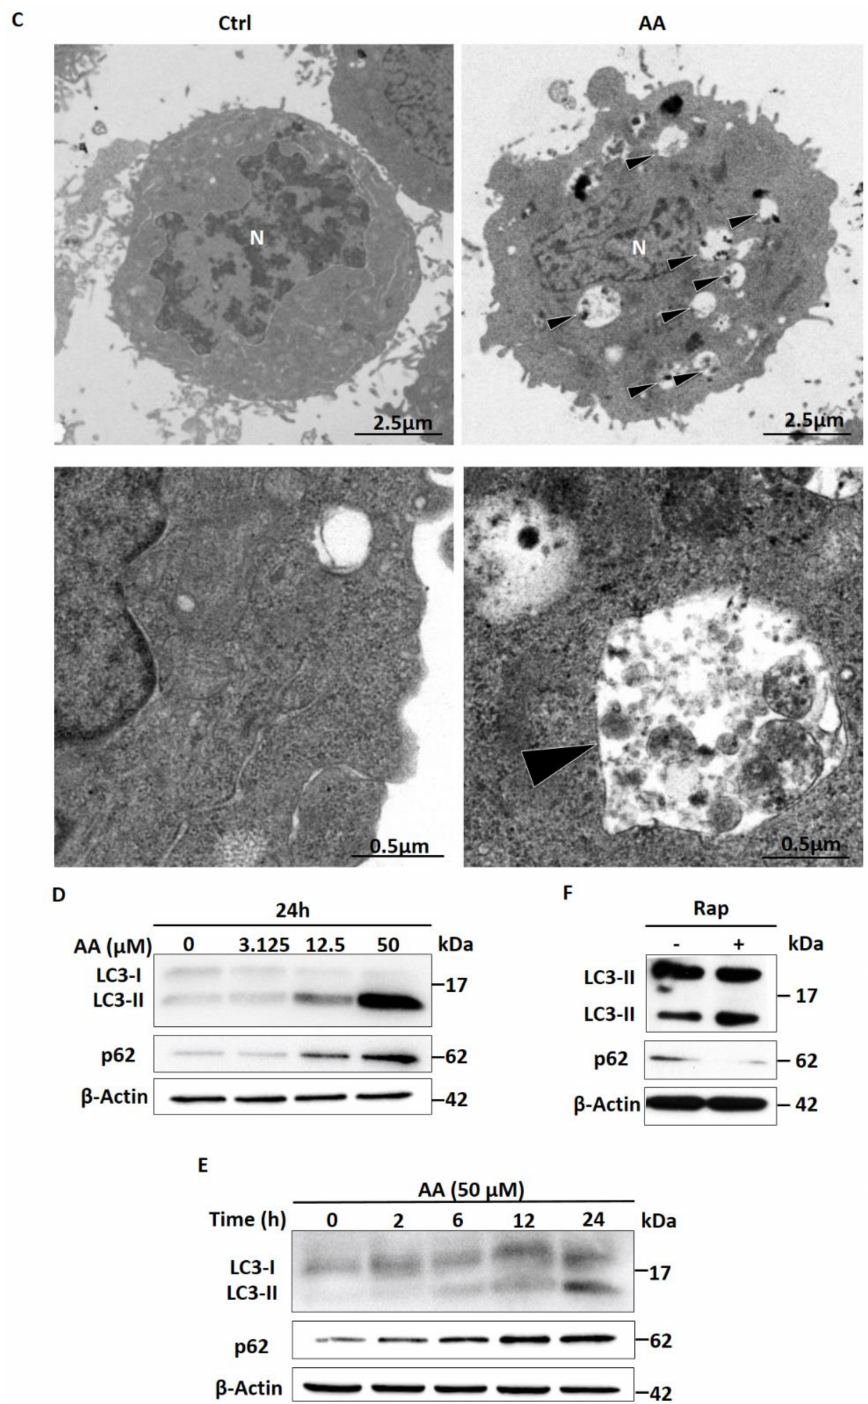
Figure 2. AA induced autophagy dysregulation in HepG2 cells. ( A , B ) A large number of LC3 positive puncta (mean = 50, n = 54) are seen after AA treatment. In contrast, fewer than 10 LC3 puncta (mean = 3, n = 13) are observed in control cells. Student’s t -test p -value: *** p < 0.001. ( C ) AA induces the accumulation of vacuole-like structures in the cytoplasm (arrow head), while few vacuoles are observed in DMSO-treated cells. In the lower panel, higher magnification images show that AA-induced vacuoles contained cellular organelles (arrow head). ( D , E ) AA treatment causes p62 accumulation and conversion of LC3 I to LC3II in a time- and dose-dependent manner. ( F ) Rapamycin treatment leads to p62 degradation and conversion of LC3 I to LC3II in HepG2